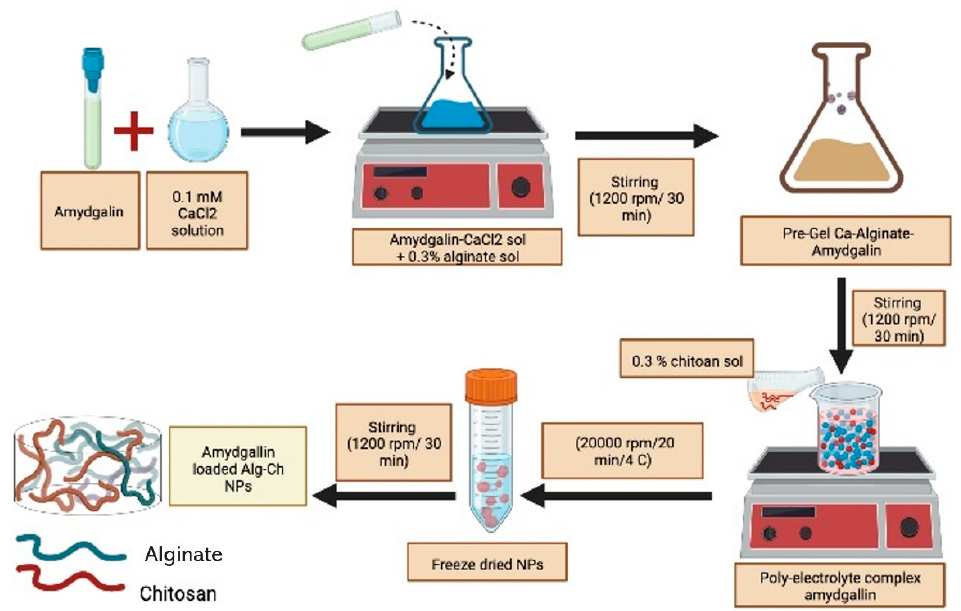
Figure 6. An illustration showing how anionic and cationic ACNPs loaded with amygdalin are made.